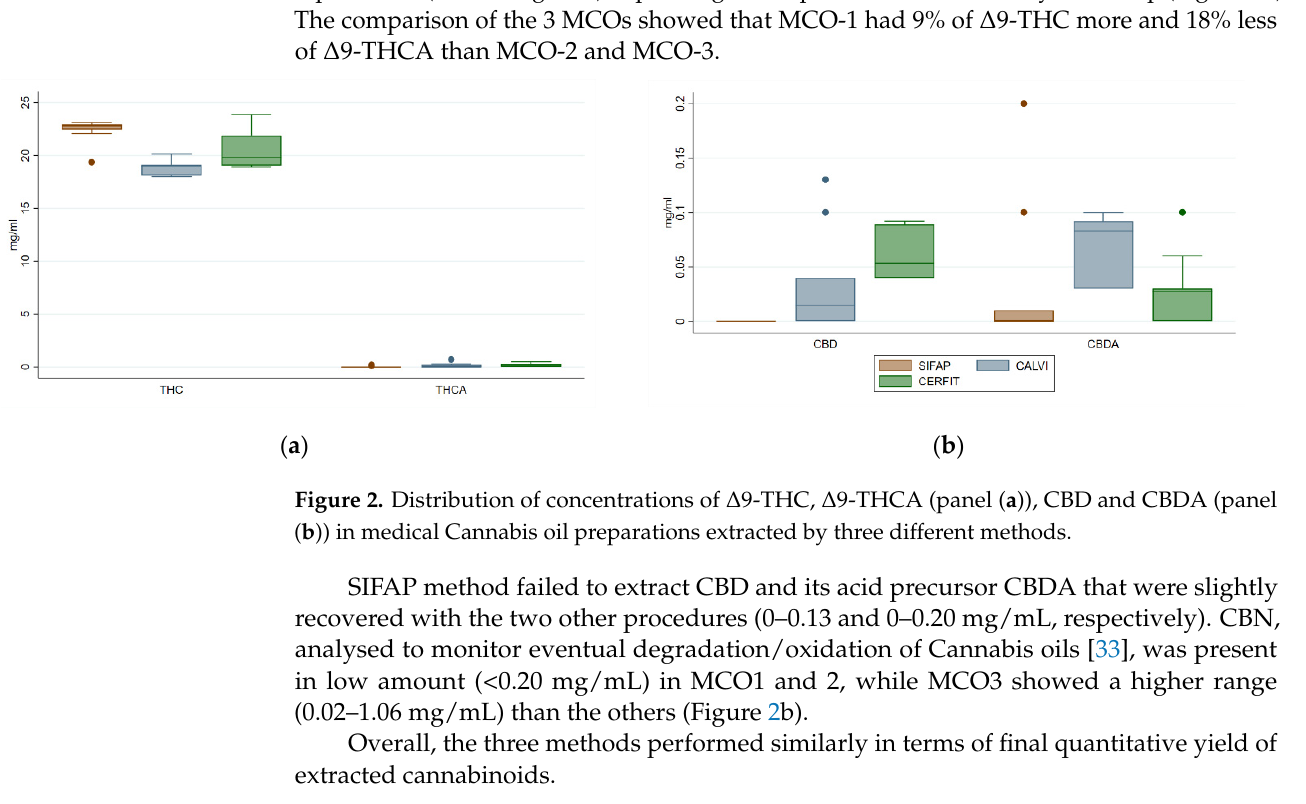
9 of 17 Figure 1. HPLC-MS/MS mass chromatogram of a standard calibration point for analytes involved in the study. Neutral psychoactive Δ 9-THC concentration was high and consistent through all